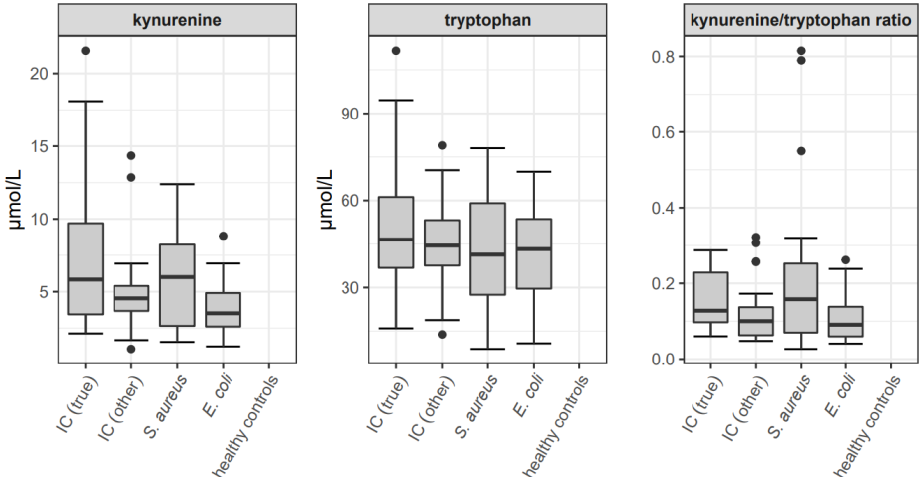
Figure 3. Boxplots of kynurenine and tryptophan concentrations as well as the kynurenine/trypto- phan ratio for the total study population at time interval (−1;2) (relative to index sampling). Except for the ratio, values are given in µmol/L. In the boxplots, median values are depicted as bold line and the box spans from first to third quartile; whiskers extend to a maximum of 1.5 times the inter- quartile range (IQR, third minus first quartile) out from the respective box end; all remaining values are indicated as dots. IC = invasive candidiasis. IC (true) = patients with true candidemia. IC (other) = patients with candidemia of unclear significance (positive blood cultures from central veins only), proven IC other than candidemia, and patients with probable and possible IC. S. aureus = patients with S. aureus bacteremia. E. coli = patients with E. coli bacteremia. Referring to kynurenine levels, the only statistically significant difference for time interval ( − 1; 2) was observed between patients with IC (true) (median 5.8, range 2.1–21.6 pg/mL) and patients with E. coli bacteremia (median 3.5, range 1.2–8.8 pg/mL), with significantly elevated kynurenine values in true candidemic patients ( p